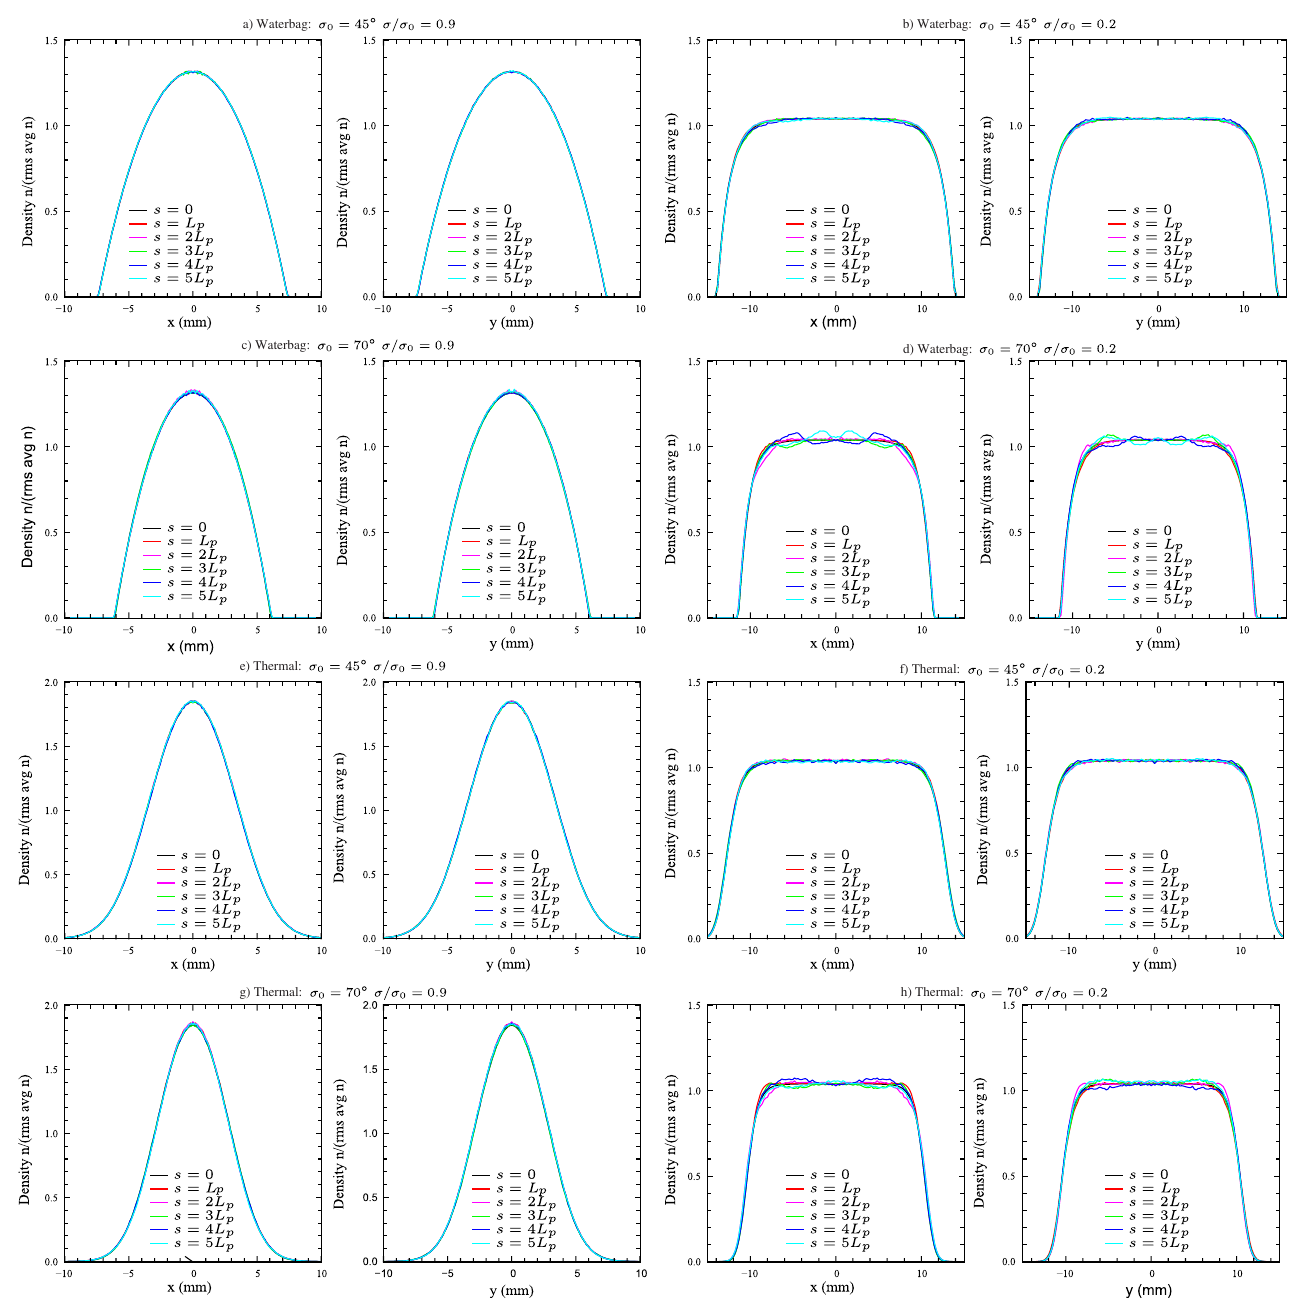
FIG. 6. (Color) Transient evolution of the beam density n of initial pseudoequilibrium distribution loads for: (a) waterbag form: ¼ 45 (cid:5) , (cid:3)=(cid:3) ¼ 0 : 9 ; (b) waterbag form: (cid:3) ¼ 45 (cid:5) , (cid:3)=(cid:3) ¼ 0 : 2 ; (c) waterbag form: (cid:3) (cid:3) 0 0 0 0 ¼ 70 (cid:5) , (cid:3)=(cid:3) ¼ 0 : 2 ; (e) thermal form: (cid:3) ¼ 45 (cid:5) , (cid:3)=(cid:3) ¼ 0 : 9 ; (f) thermal form: (cid:3) (cid:3) 0 0 0 0 ¼ 0 : 9 ; (h) thermal form: (cid:3) ¼ 70 (cid:5) , (cid:3)=(cid:3) ¼ 0 : 2 . Density profiles are shown along the principal x and y axes at lattice 70 (cid:5) , (cid:3)=(cid:3) 0 0 0 ¼ 50 , N ¼ 40 k , N ¼ 100 , N ’ 3 period intervals. ( WARP : N r s p ppg